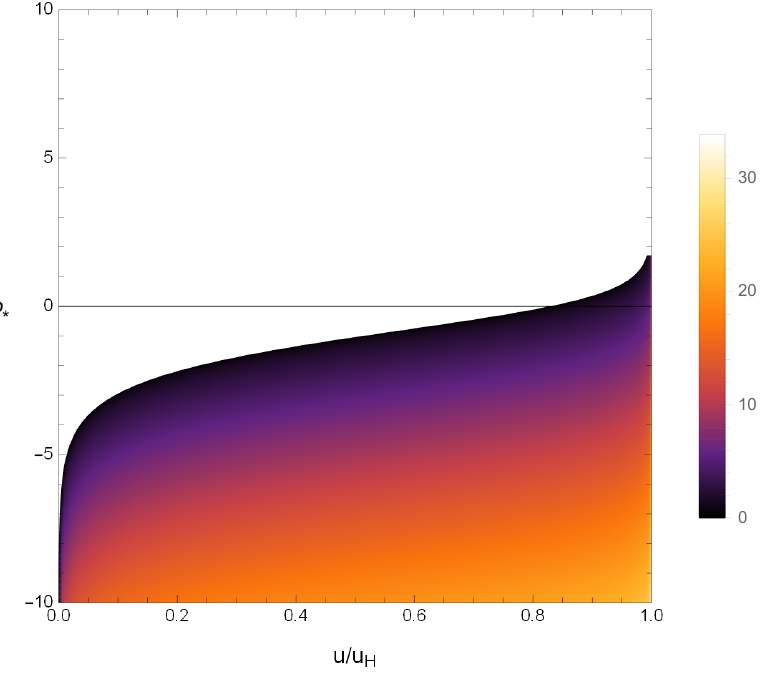
Figure 11 . A density plot of the Page time t Page , in the special case u = u L = u R . The plot cuts off at t Page = 0 , at the boundary given by the Page angle plot in figure